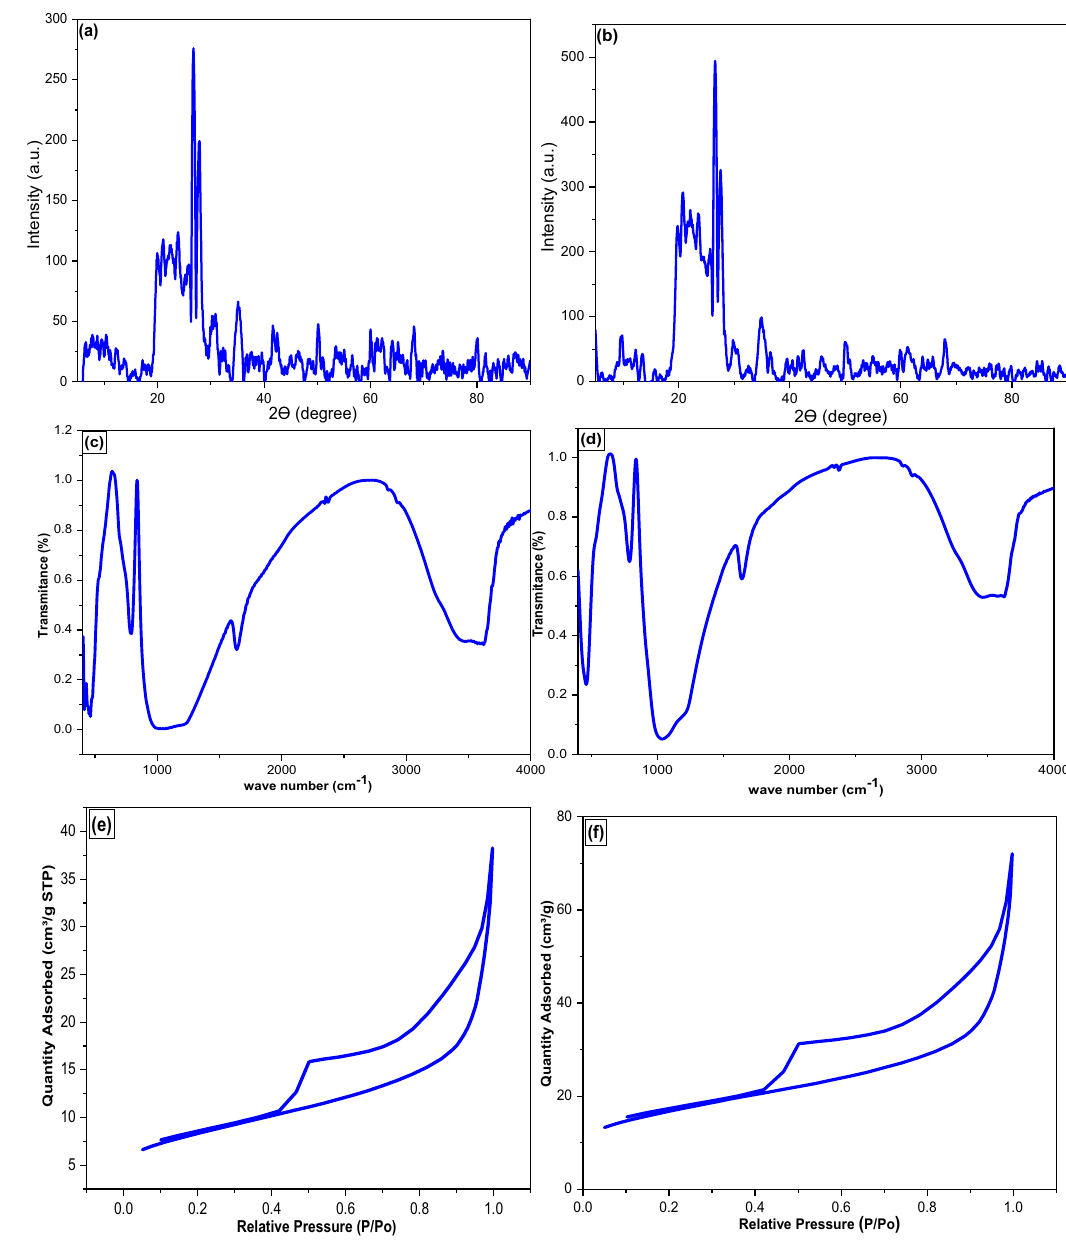
Figure 2. ( a , b ) XRD pattern of WTC and ATC, respectively; ( c , d ) are the FTIR results of WTC and ATC, respectively; ( e , f ) are the N2 adsorption–desorption isotherms results of WTC and ATC,